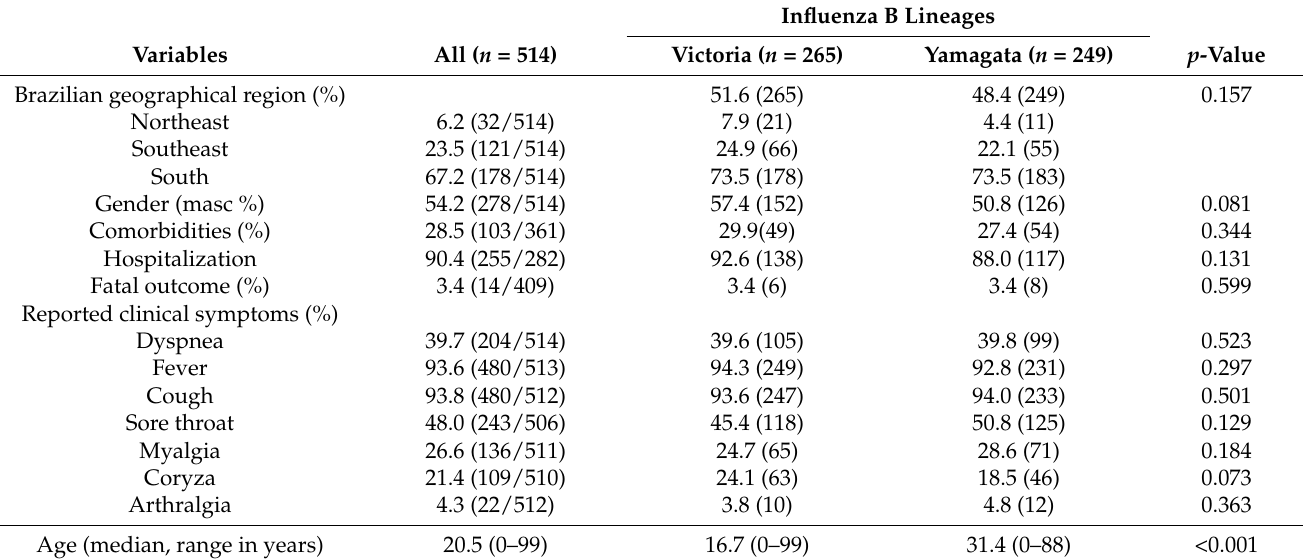
Table 1. Demographic and clinical features among the 514 Influenza B infected individuals, according to viral lineage in Brazil,